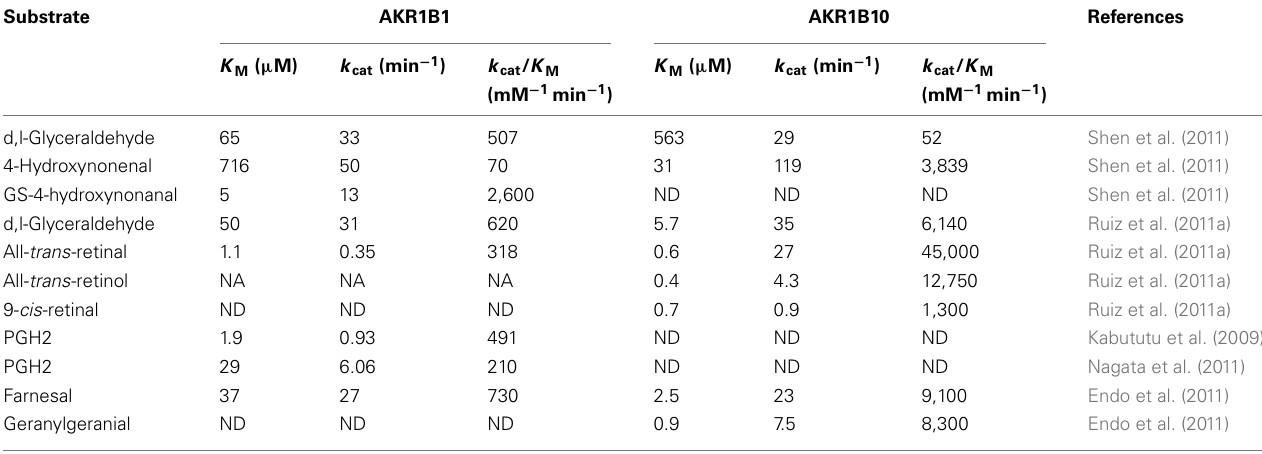
NA, no activity; ND, not determined.